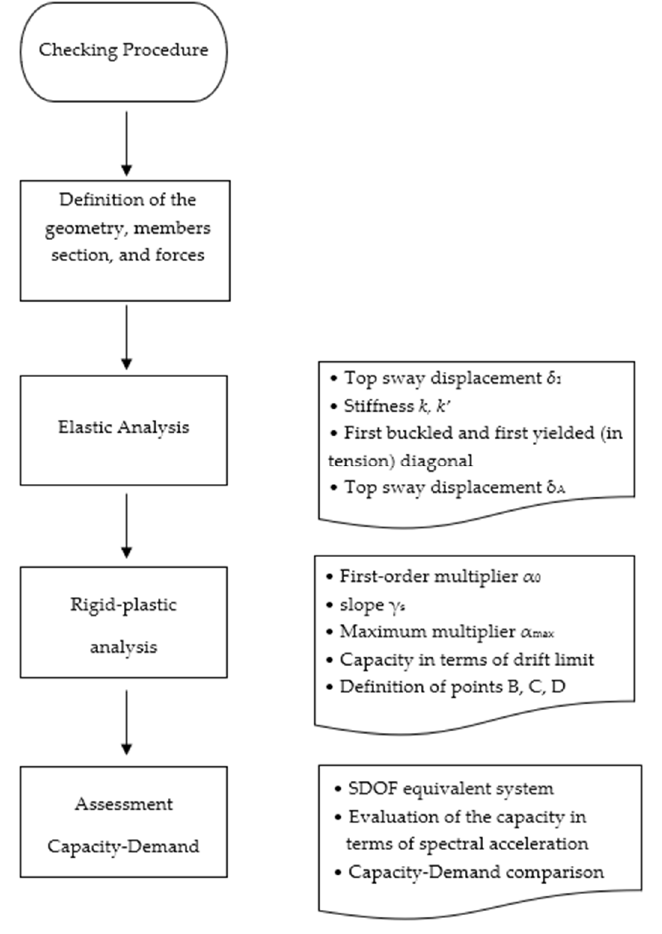
Figure 4. Flowchart of the procedure.